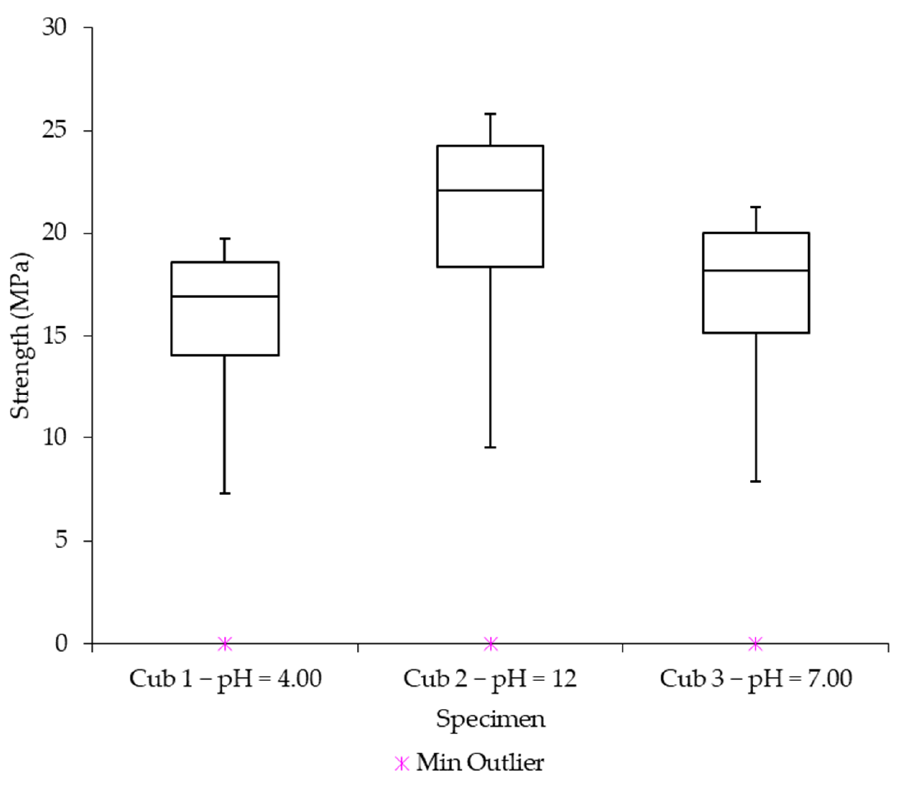
Figure 6. Strength gain data distribution.